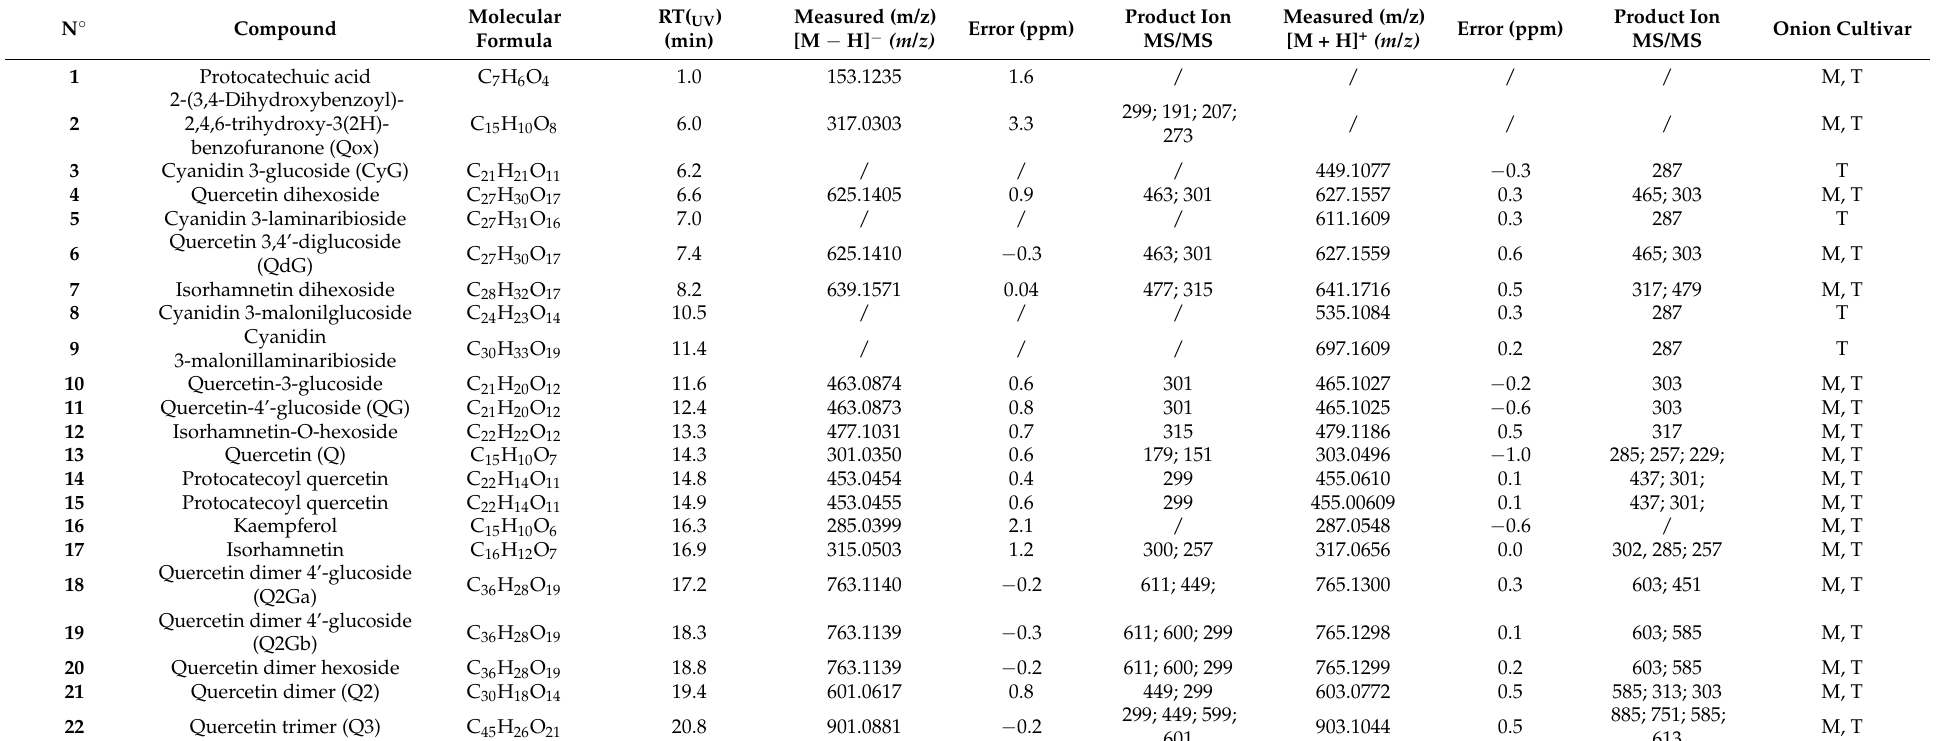
Table 1. UHPLC-HRMS/MS data of detected compounds in “Ramata di Montoro” (M) and “Rossa di Tropea” (T) onion-dried skin